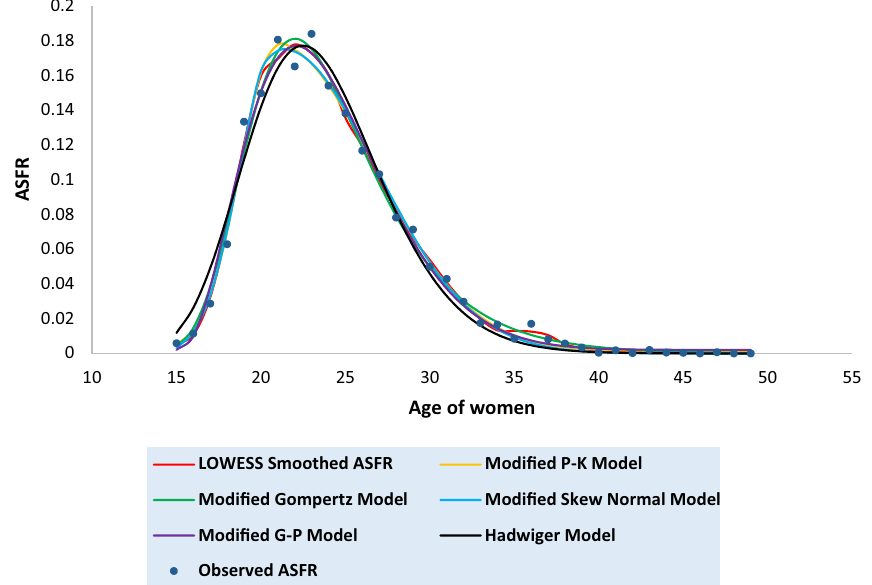
Figure 9. Observed and expected age-specific fertility rate (ASFR) for Karnataka under different proposed models and Hadwiger model.